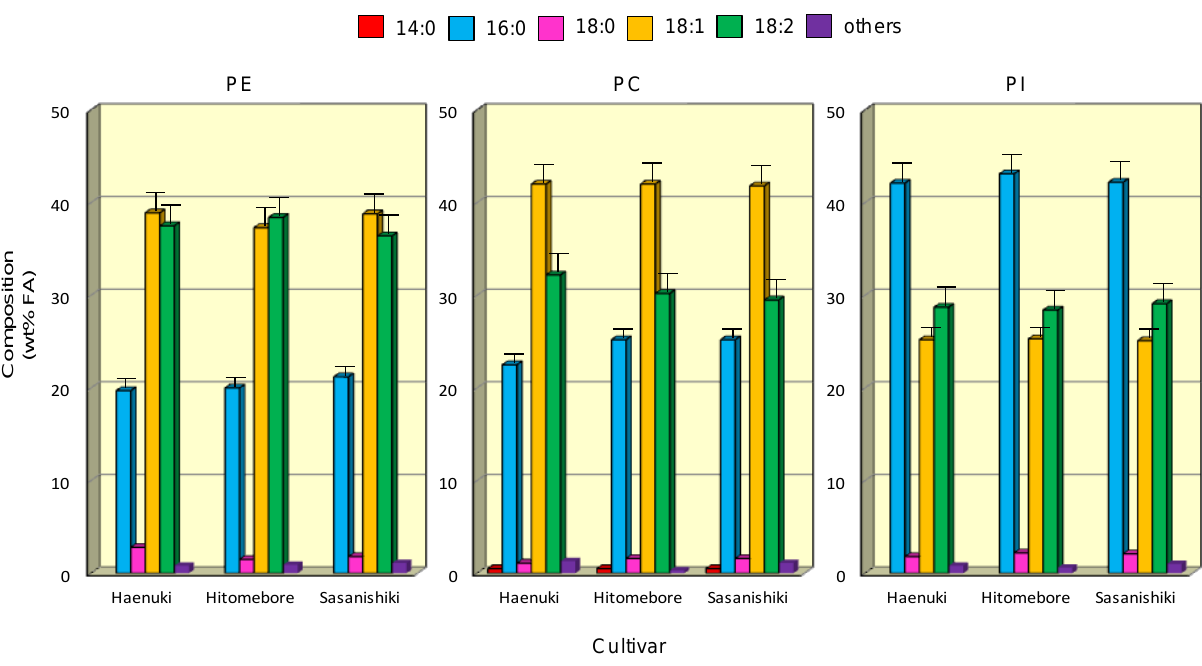
Figure 5. FA profiles for the major PL (PE, left panel; PC, middle panel; and PI, right panel) prepared from rice brans. Each value represents the average of three replicates, and vertical bars depict the mean and standard deviation. “Others” include minor FA such